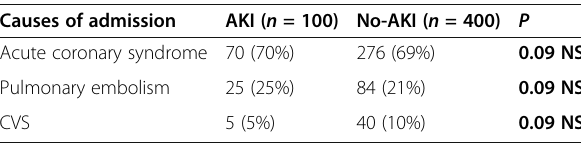
Table 2 Causes of admission in studied patients based on development of acute kidney injury